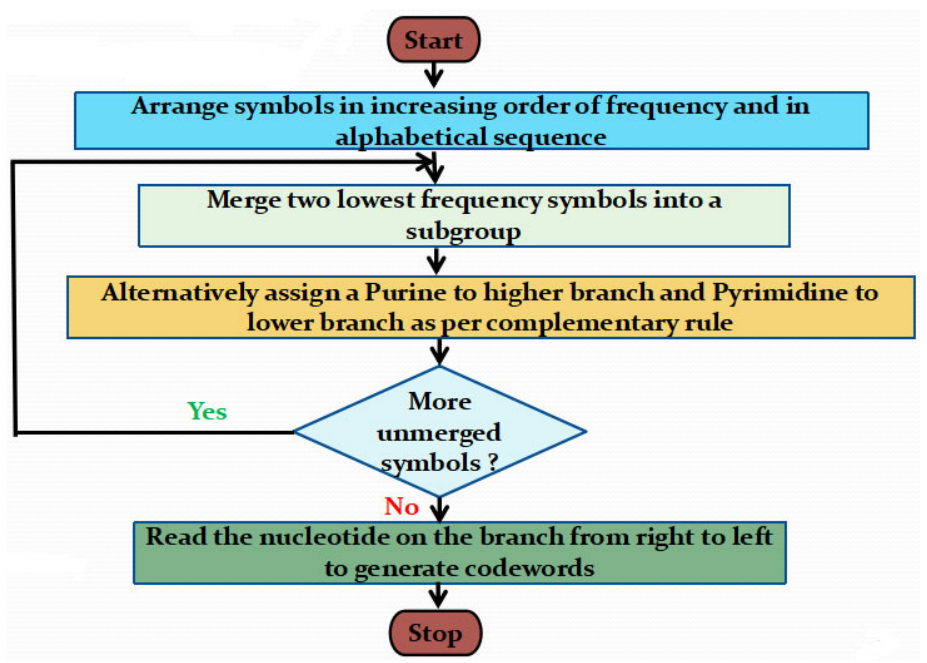
Figure 1. Flowchart of Proposed DNA ‐ based Huffman Coding Scheme. Algorithm s 1: Proposed DNA ‐ based Huffman Coding Scheme